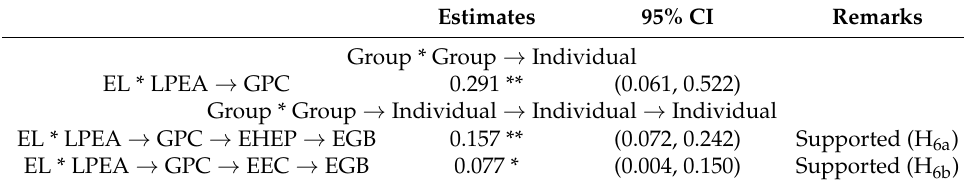
Table 5. Summary of moderation